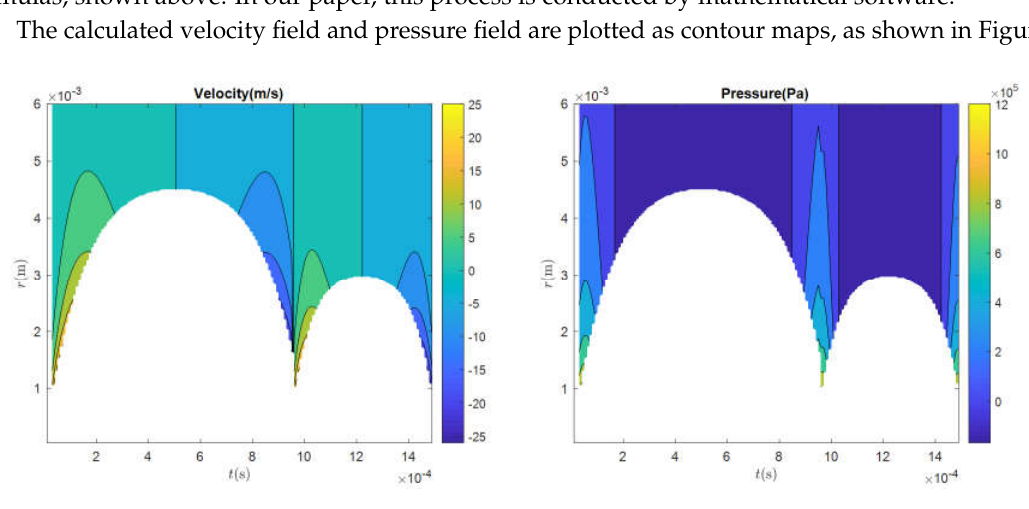
Figure 8. The velocity and pressure contour maps, obtained by the analytical method.